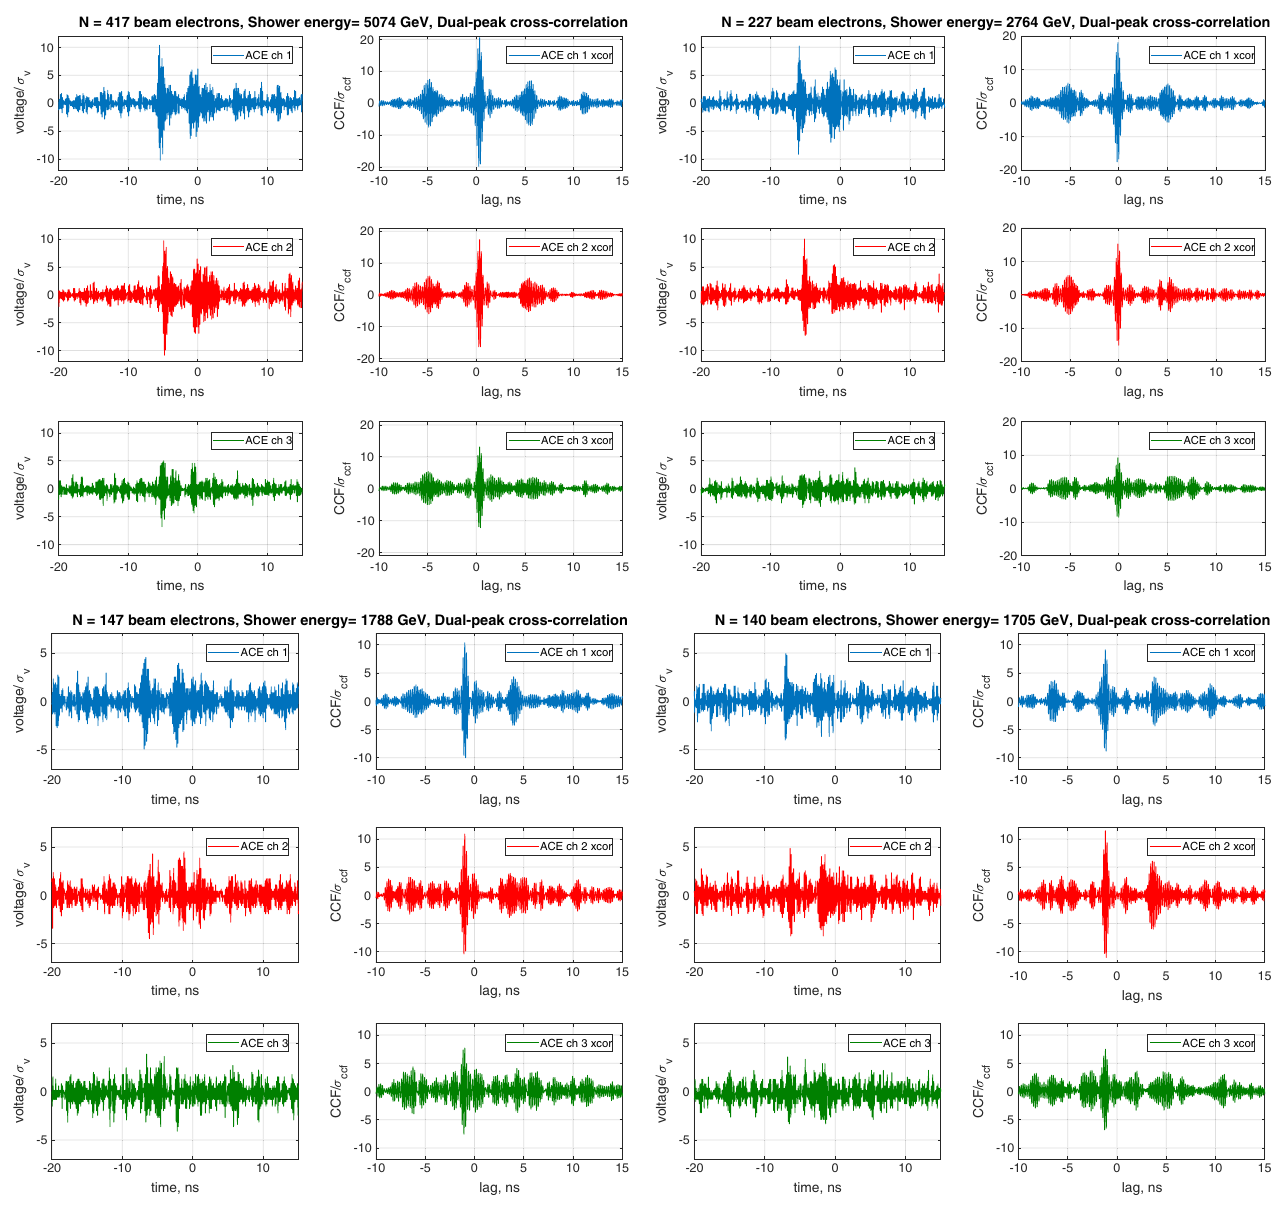
FIG. 11. Four typical ACE events at low beam currents, with decreasing total shower energy from upper left to lower right. On the left in each set of plots is the measured voltage from each element, normalized to the thermal noise rms; on the right is the template cross- correlation function, also normalized to its rms noise level. Approximate time offsets are removed from the time axes of the data, giving CCF lags that are close to zero, but not required to coincide with